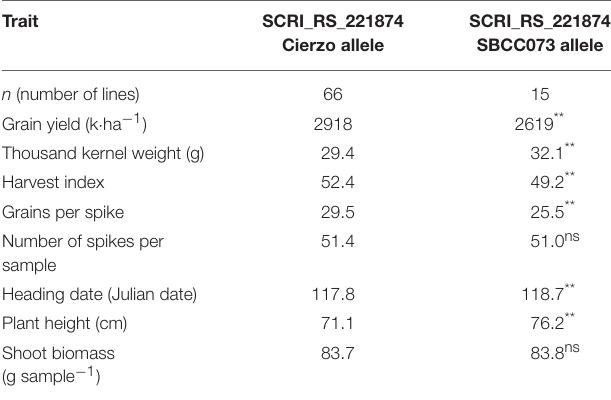
TABLE 5 | Results of the validation trial for the marker at the QGY.73 × C.6.1 peak in the 2017–18 season.